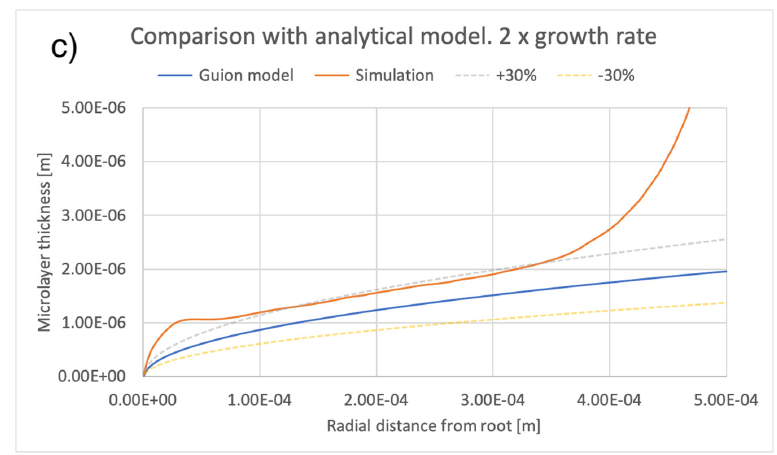
Figure 14. Comparison of current simulation results with the model of [12] ; effect of bubble growth rate. Radial distributions of microlayer thickness corresponding to the same bubble volume, presented in Figure 11, are compared with predictions of the model of [12] . Panels ( a – c ) show microlayer profiles for different values of the bubble growth rate.